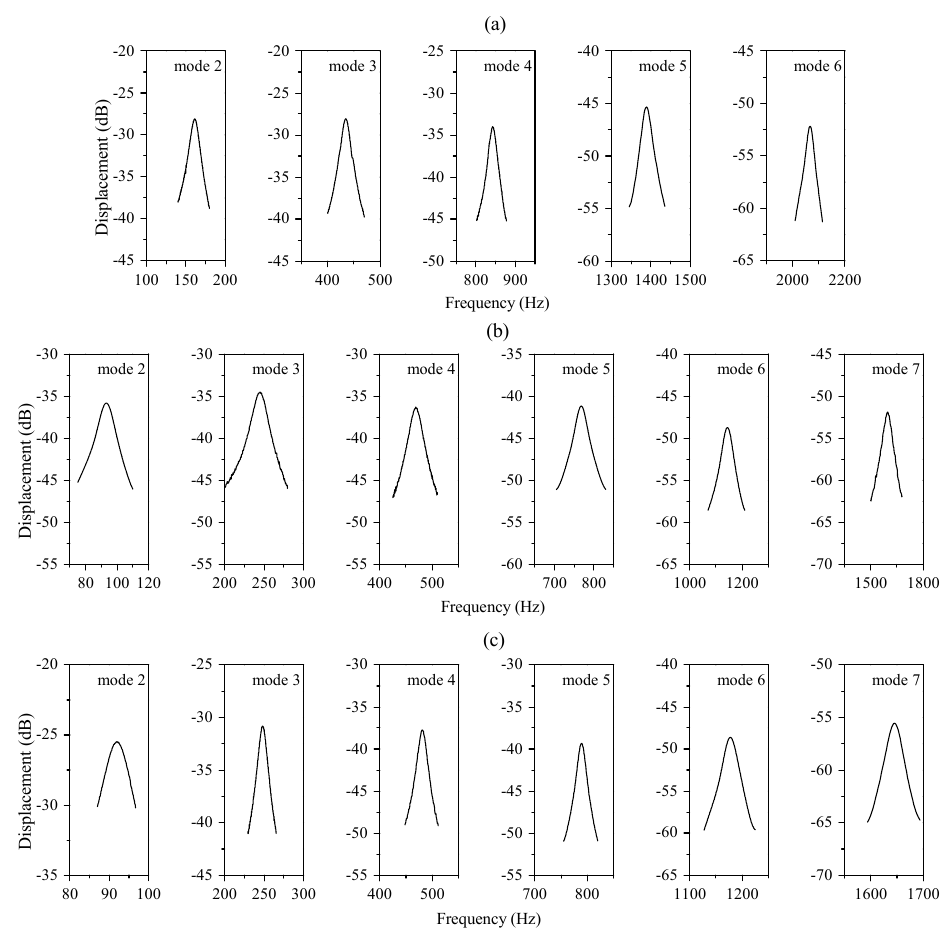
Figure 9. Normalized frequency responses of sandwich beam specimens by narrow band excitation: ( a ) short asymmetrical specimen ( b ) long asymmetrical specimen and ( c ) long symmetrical specimen.